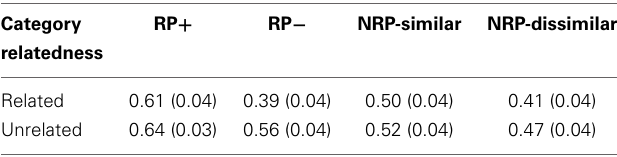
Table 1 | Final recall test performance for each item type in Experiment